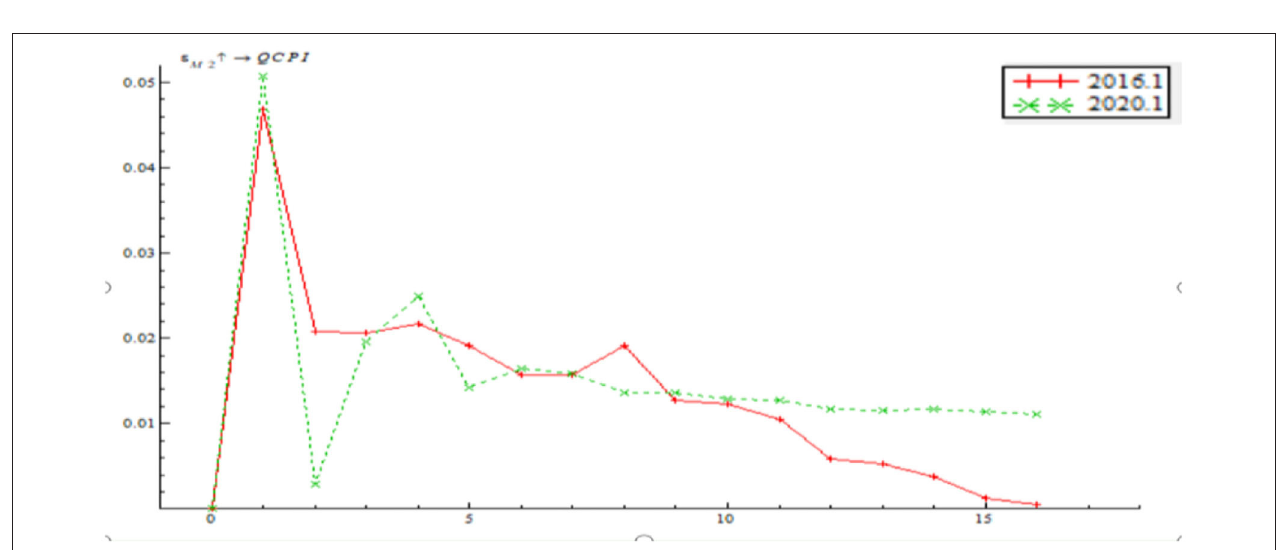
FIGURE 13 | Time point-based shock of quantitative monetary policy on inflationary